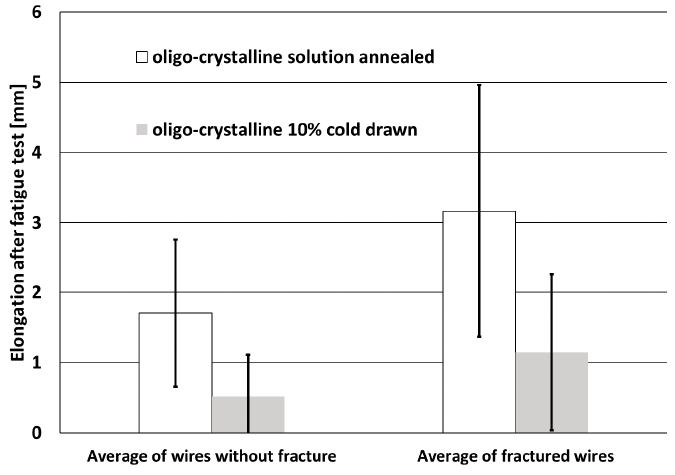
Figure 5. Elongation after fatigue testing of fatigue tested wires without rupture and fractured wires.